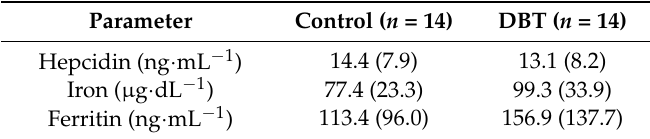
Table 3. Basal iron status of participants.